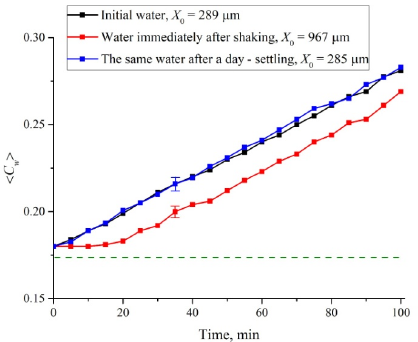
Figure 13. Average (over the distance L = 200 μm between the windows of the cell) concentration of water C w ( t ) vs. the time of swelling for initial water, water subjected to shaking, and water that settled for one day after shaking. The estimates of X 0 (see Reference [24] for more detail) are also given. The dashed line is the water concentration for dry Nafion.